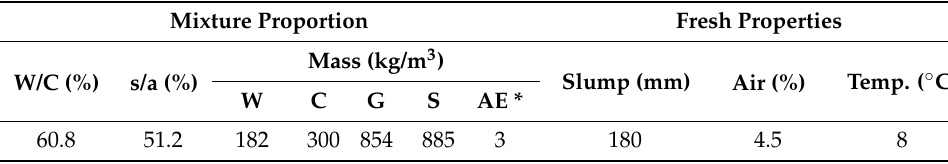
Table 1. Mixture proportion and properties of the fresh concrete.